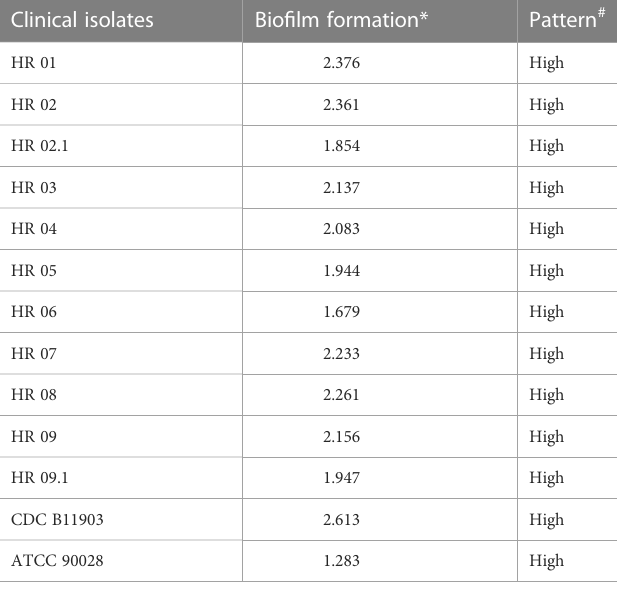
TABLE 2 Bio fi lm formation capacity on the polystyrene surface of clinical isolates of C. auris in 24 h. Clinical